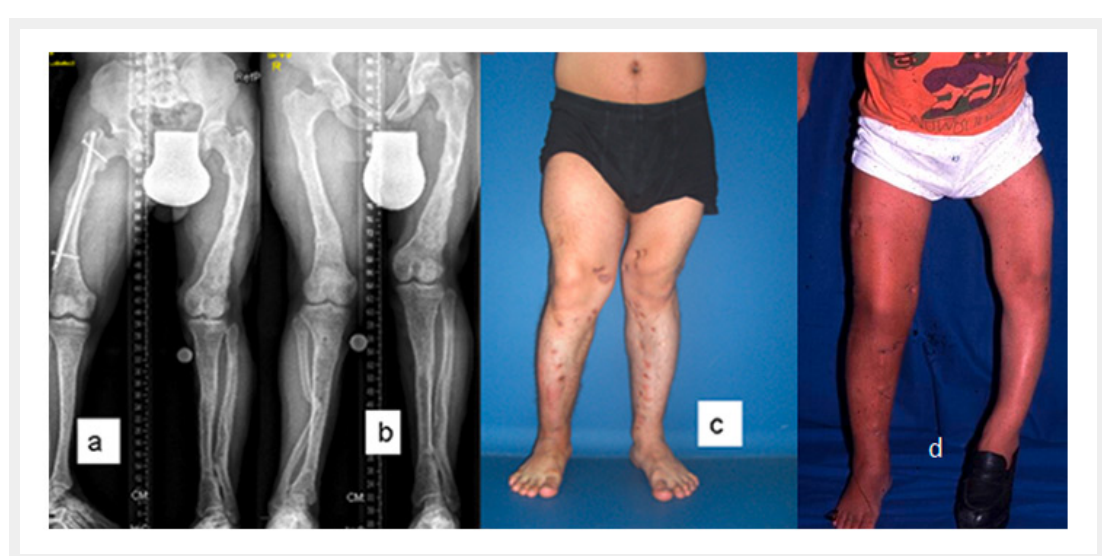
Figure 4 Clinical status after corrections in four patients. (a) After full correction and acceptable bony consolidation, an intramedullary fixation by means of locked nails was inserted along the right femur and the patient was able to stand. (b) Alignment and orientation are best judged using standing long anteroposterior view radiographs of the entire lower extremity. (c) Orthopaedic interventions to realign the lower limbs in our patients were successful in producing a better balance and gait in these children, thereby our patients were able to stand almost normally. (d) A patient’s photograph shows the results of correcting the deformity and the results of the re-alignment of the lower limbs. The average postoperative valgus deformity in our patients was 8.2° and the average varus deformity was